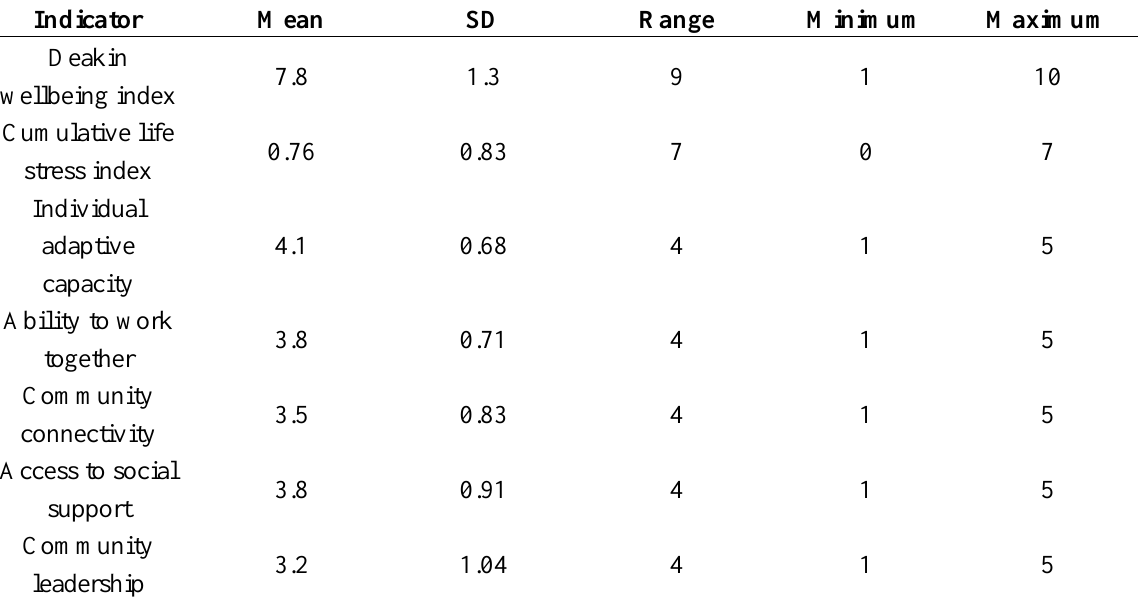
Table 2. Descriptive statistics for the indicators used in this